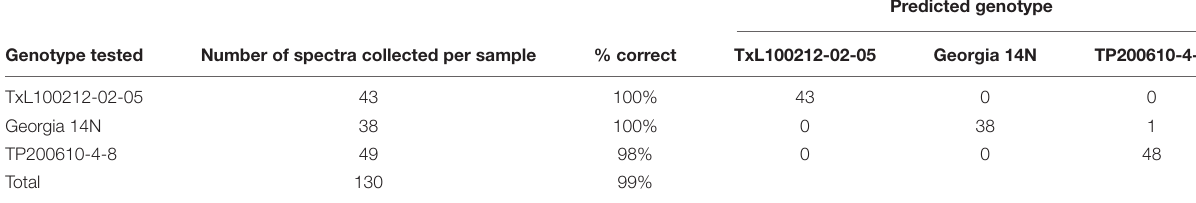
TABLE 4 | PLS-DA cross-validation confusion matrix of Raman spectra collected from leaves of three different genotypes of peanuts.